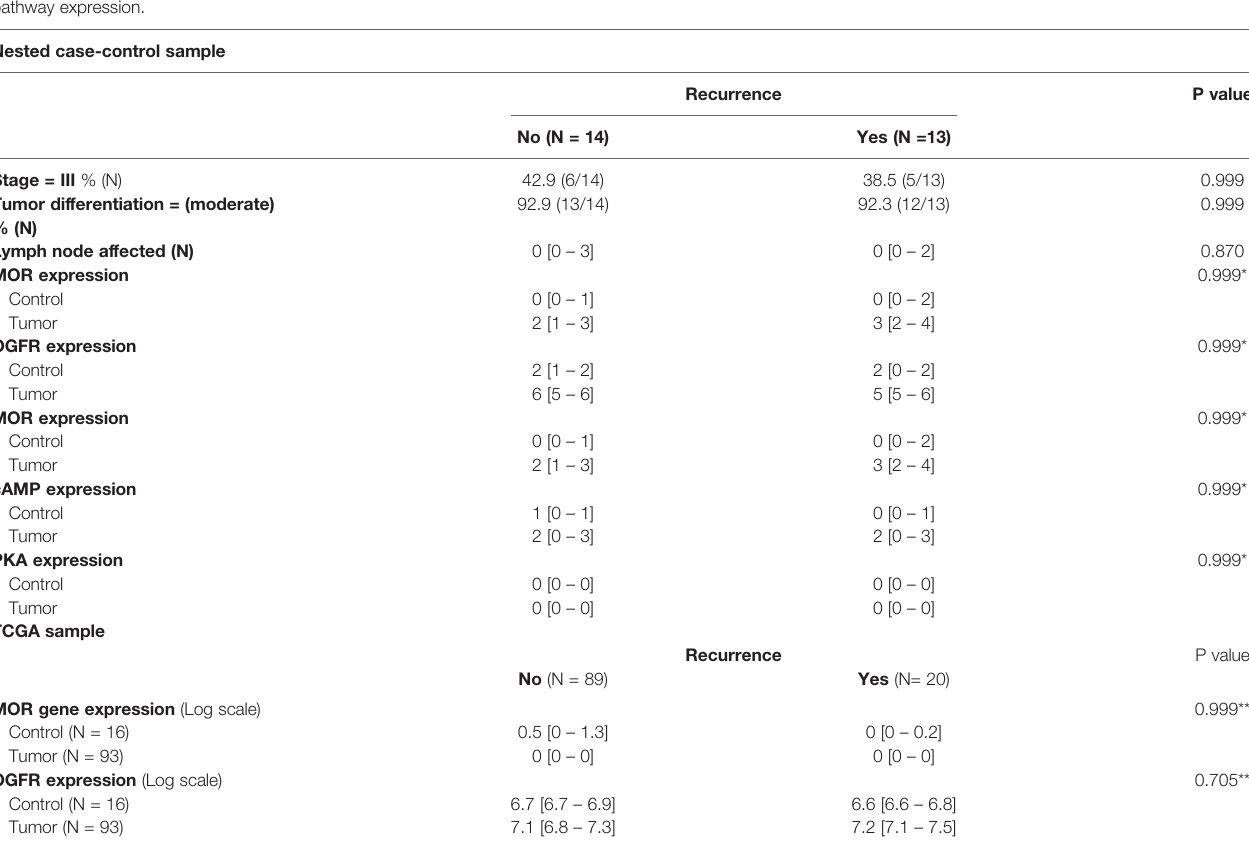
TABLE 1 | Sample baseline characteristics, receptors, and metabolic pathway